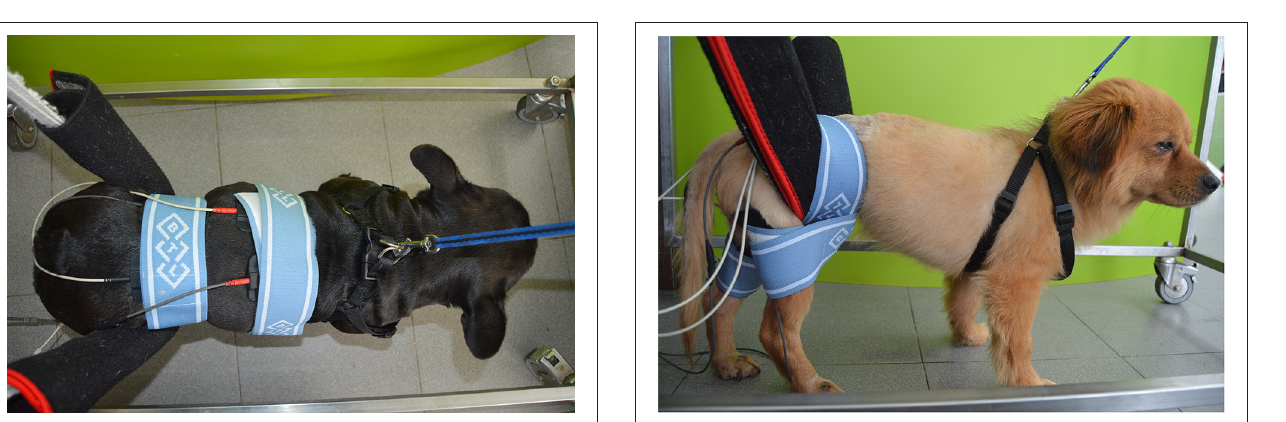
FIGURE 2 | Interferential electrical stimulation (IES) for pain management in postural standing position. Application of two different channels with four electrodes in a crossed position.